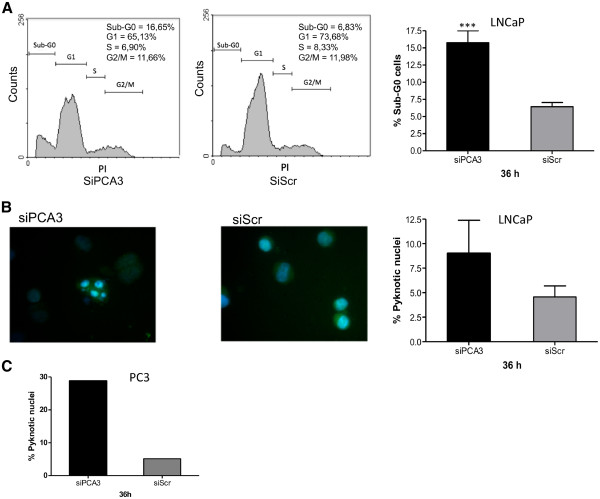
PCA3 knockdown induces cell cycle arrest and apoptosis in LNCaP cells. (A) Representative histograms of LNCaP cells 36 h after transfection with siPCA3 or siScr (left panels). Flow cytometry was used to quantify the percentage of cells undergoing apoptosis (cells in sub G0-G1), which are shown in the bar graph on the right panel. The data represent the means ± S.D. from three independent experiments (right panel). The asterisks indicate significant differences between siPCA3 and siScr control-treated groups (*** p < 0.001). (B) Nuclear morphological changes characteristic of apoptotic cells in LNCaP cell cultures transfected with siPCA3 or siScr (left panels) were analyzed. A representative experiment is shown. Following fixation and staining with DAPI, LNCaP cells transfected with siPCA3 or siScr were examined and photographed using a fluorescence microscope as described in the Methods section. The number of pyknotic nuclei in each experimental sample was counted, and is represented on the bar graph in the right panel as the percentage of cells with pyknotic nuclei in relation to the total number of cells counted. (C) Nuclear morphological changes characteristic of apoptotic cells in PC3 cell cultures transfected with siPCA3 or siScr (left panels) were analyzed, and the results represented as described for LNCaP cells in (B). The data represent the means ± S.D. from three independent experiments (right panel).